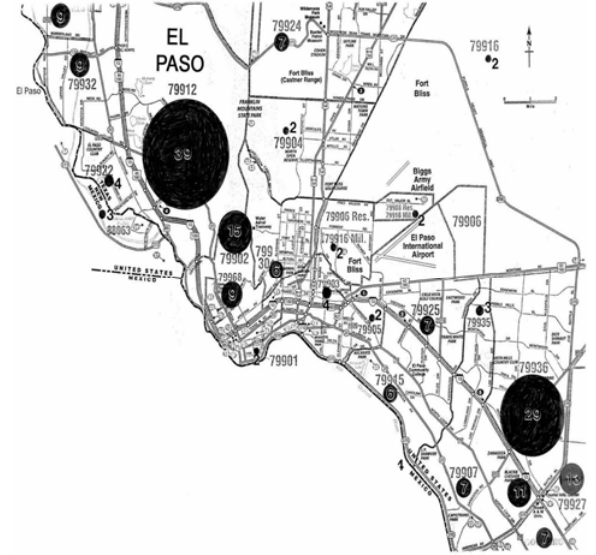
Figure 16: El Paso, TX, USA City map showing survey responses by zip code.